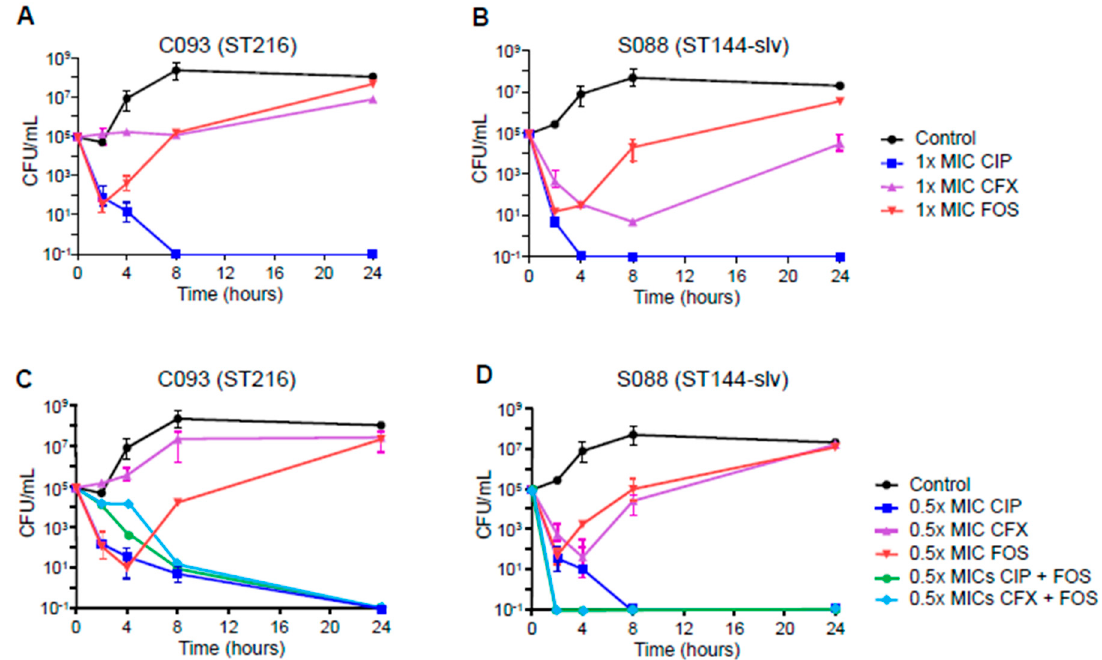
Figure 1. Time-kill curves for ciprofloxacin, cefixime, and fosfomycin against susceptible E. coli isolates, C093 (ST216) and S088 (ST144-slv). ( A and B ), the results of 1× MICs of single antibiotics, ( C and D ), the results of 0.5× MICs of single and combination of antibiotics. CIP, ciprofloxacin; CFX, cefixime; FOS, fosfomycin.